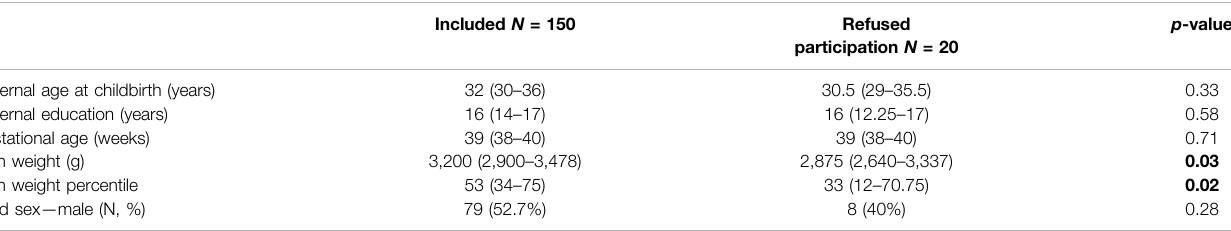
TABLE 1 | Selected maternal and child characteristics in the EHF-Assaf-Harofeh-Ichilov birth cohort, Israel, 2013 – 2015, comparing those included ( n = 150) with those refused to answer the questionnaire ( n = 20). Included N = 150